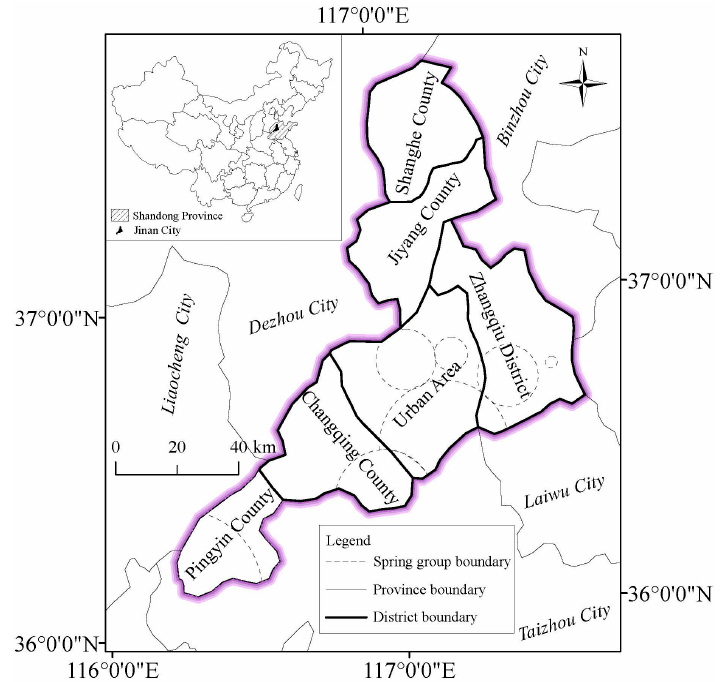
Figure 1. Map of administrative region and distribution of spring group in Jinan. Int. J. Environ. Res. Public Health 2017 , 14 , 1114